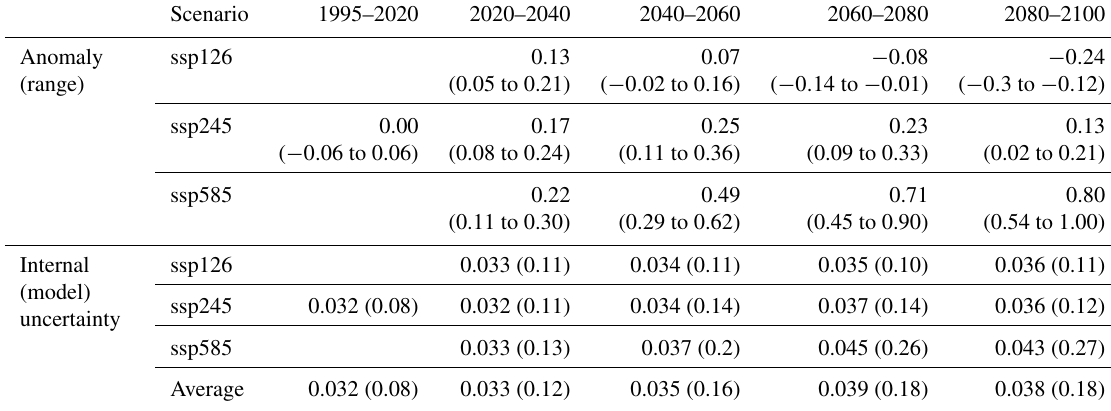
Table 1. CMIP6 multi-model mean globally averaged carbon sink anomalies (with ranges within the 20-year period in parentheses) relative to the 1995–2015 mean (in molCm − 2 yr − 1 ) and internal variability from CanESM5 (with model uncertainty in parentheses) for the globally averaged ocean carbon sink anomalies for the three scenarios and the average values across